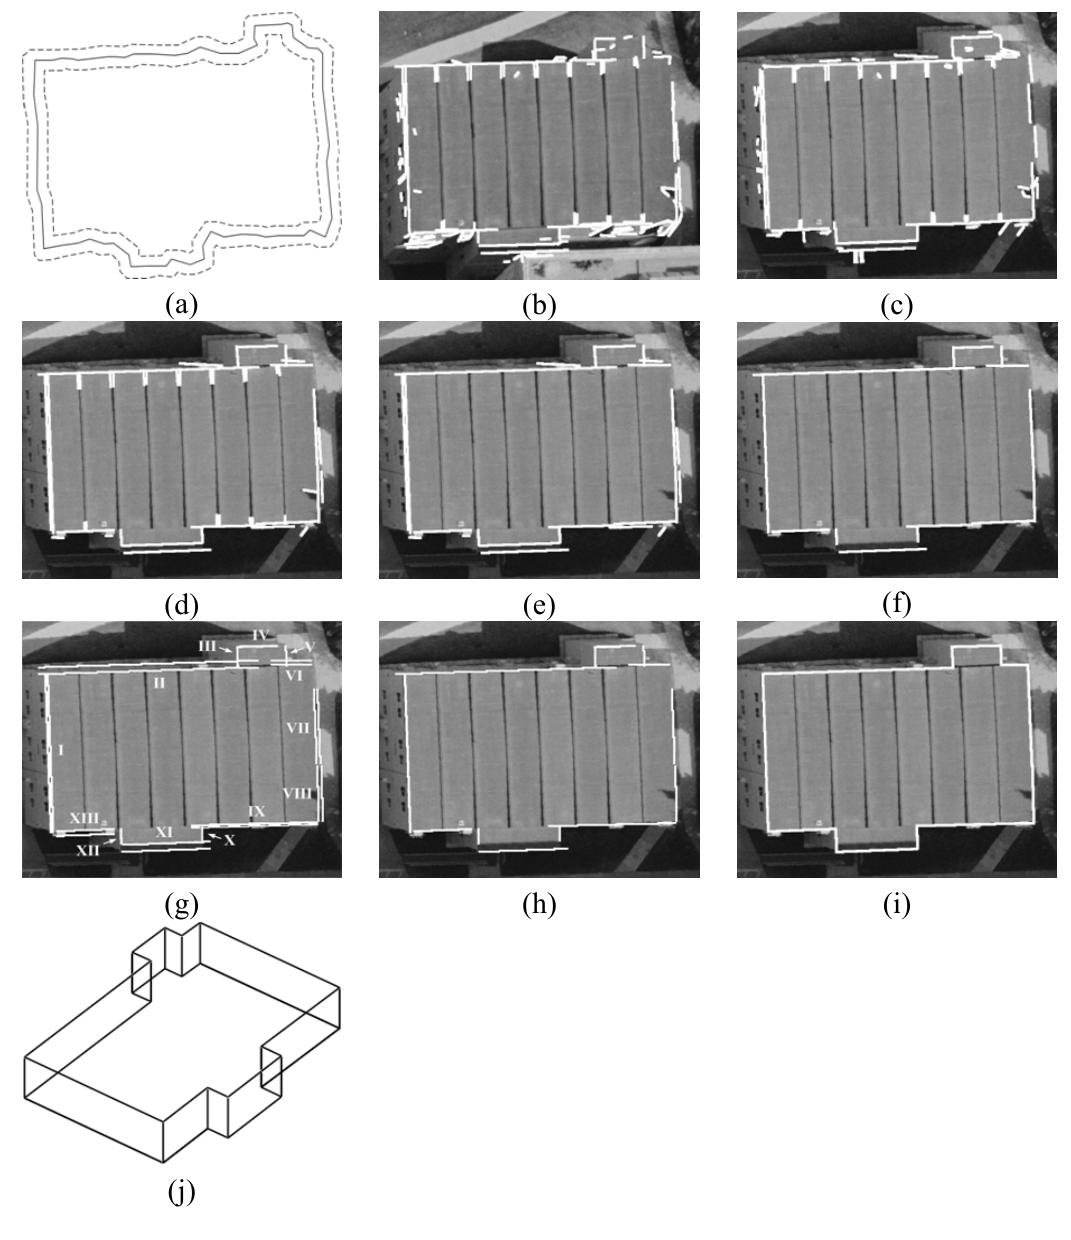
Figure 5. (a) Initial boundary of the building primitive and a buffer surrounding the boundary; straight line segments detected in the (b) left and (c) right warped images; (d) matched 3D lines; (e) filtered matched 3D lines; (f) established reference lines; (g) grouped matched 3D lines; (h) established precise boundary segments; (i) closed-polygon generated from the established precise boundary segments; and (j) generated DBM wire